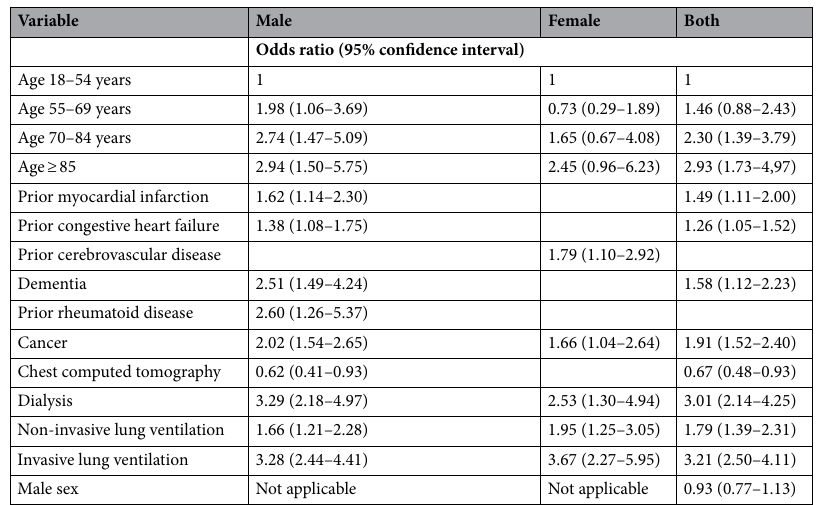
Table 7. Multivariable analysis of factors associated with in-hospital mortality during admission for community-acquired pneumonia among patients with atrial fibrillation diagnosed during hospital admission, according to sex. Odds ratios indicate those variables significantly associated with in-hospital mortality. Blank spaces denote variables excluded in the final model.